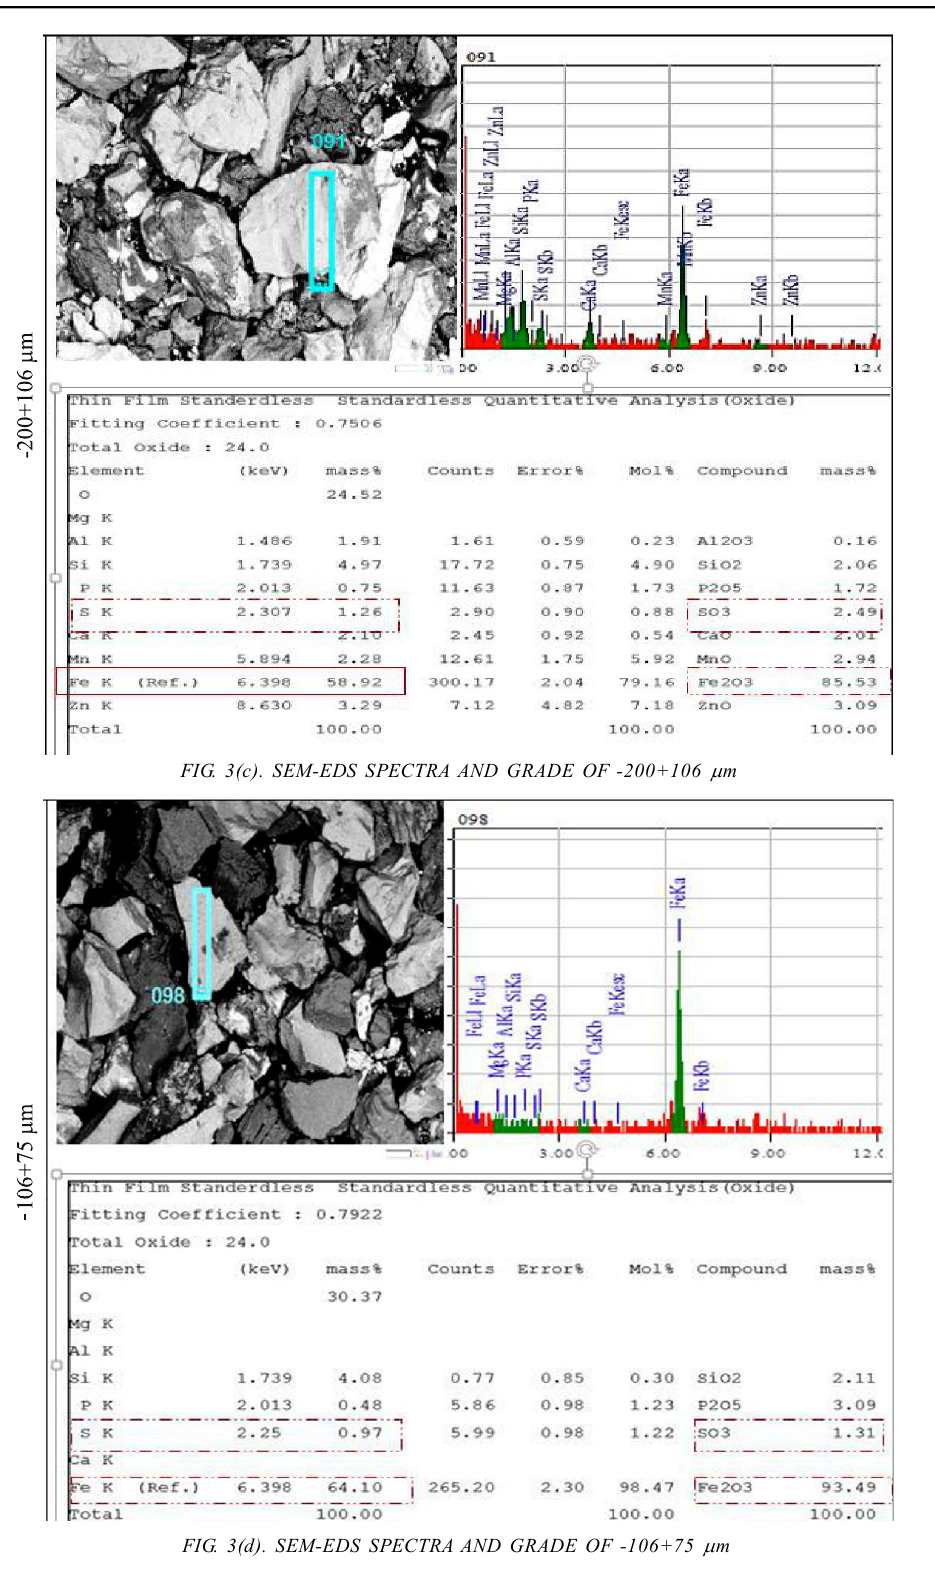
FIG. 3(d). SEM-EDS SPECTRA AND GRADE OF -106+75 